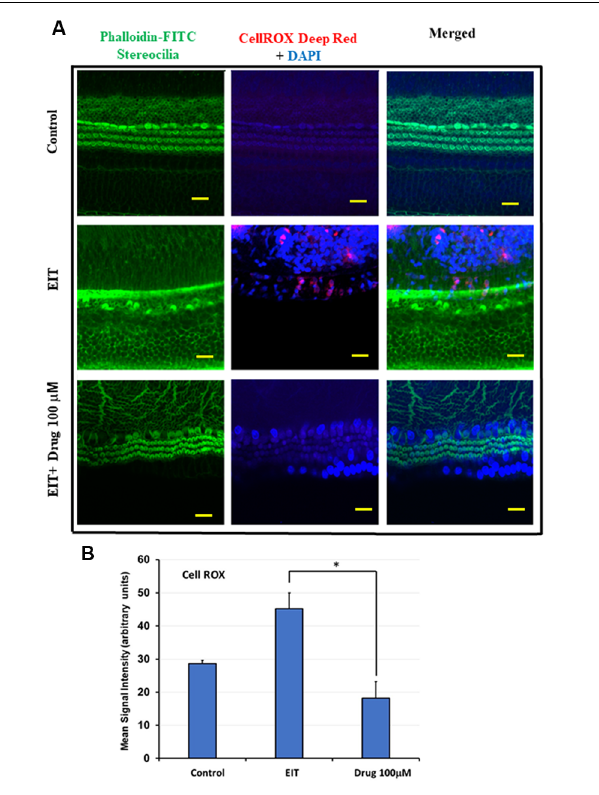
FIGURE 3 | TDCA attenuates EIT induced oxidative stress in OC explants. (A) CellROX immunostaining in OC explants subjected to EIT or EIT and treated with TDCA. The first column shows the explant’s stereocilia bundles stained with FITC-phalloidin. Cell nuclei were stained with DAPI (blue color). (B) The mean signal intensity for CellROX was calculated using ImageJ software. Data are expressed as mean values ± SD and are representative of three independent experiments. ∗ P < 0.001 compared to the EIT group. n = 6 OCs per group. Scale bars: 10 µ